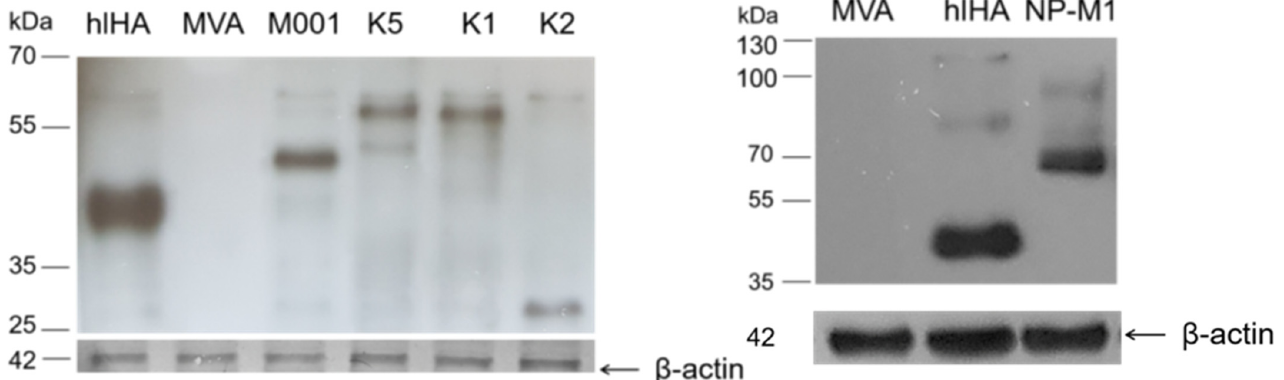
Figure 1. Western blot analysis of antigen expression in BHK-21 cells infected with rMVA-hlHA,